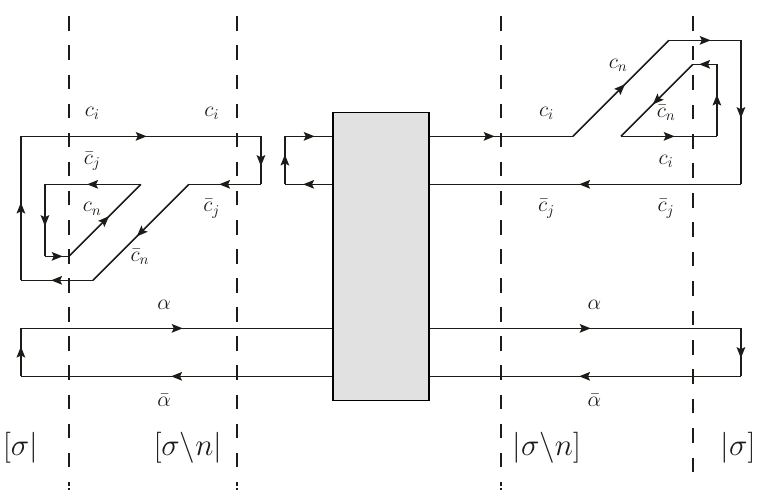
A (cid:27) ]. The vertical j j